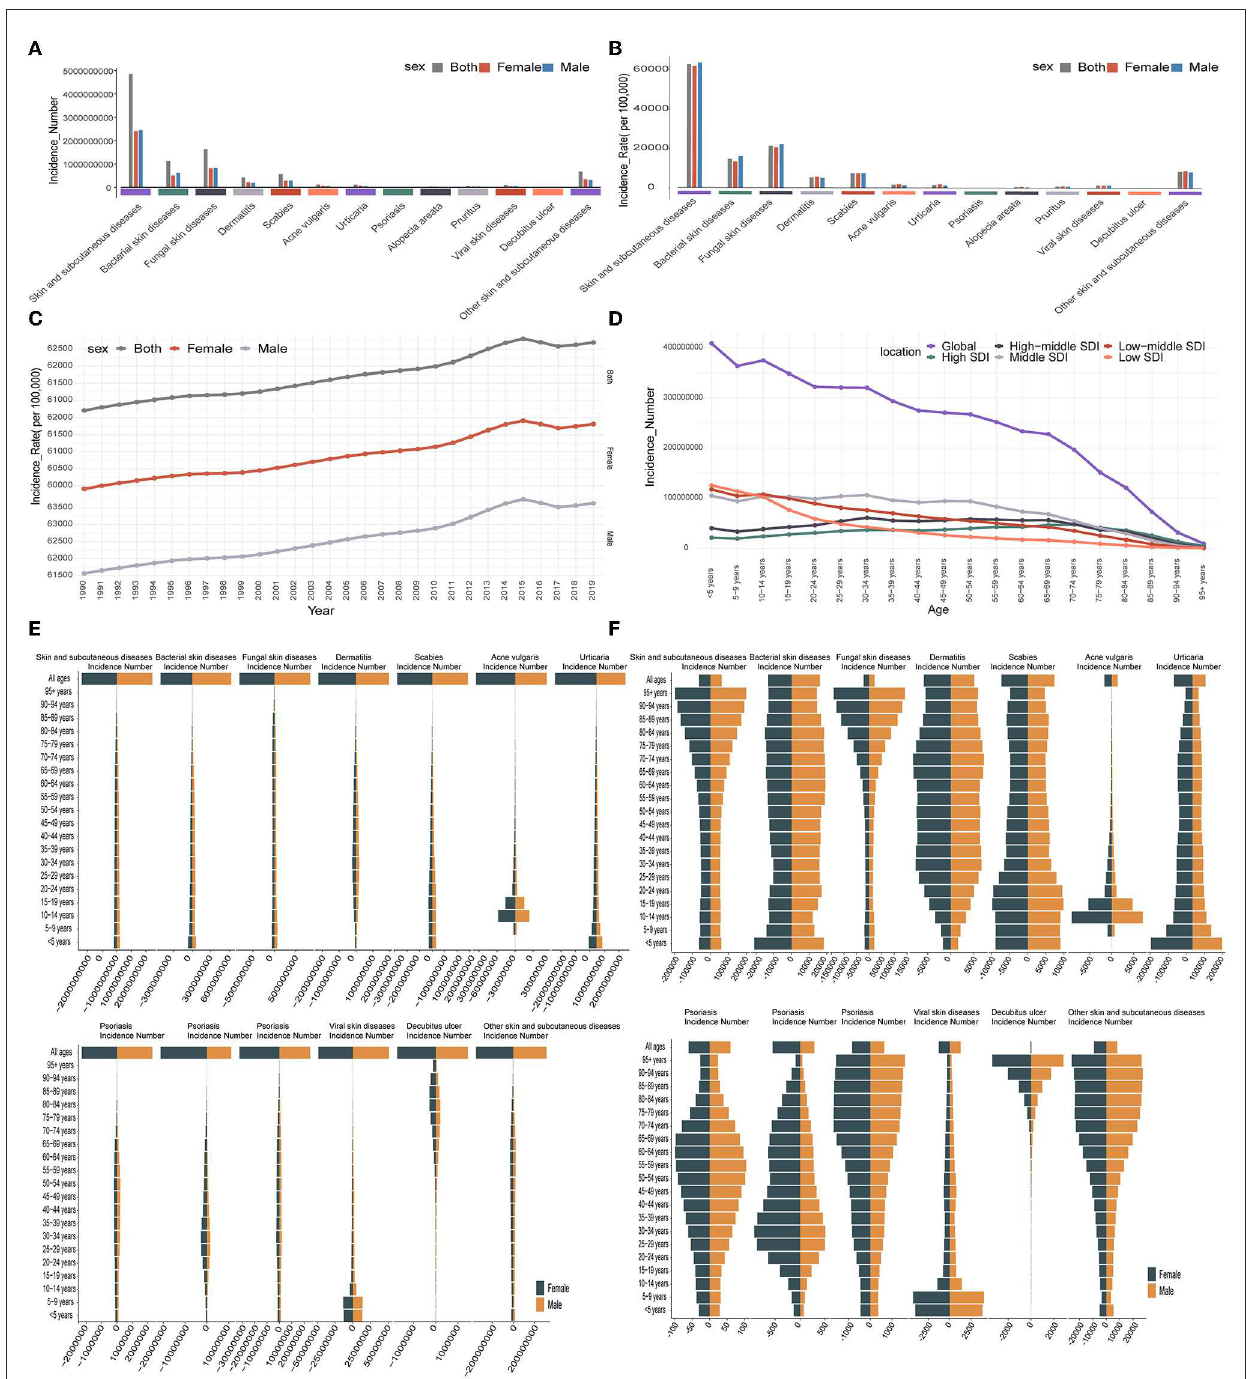
FIGURE2 Skin and subcutaneous diseases burden among different sexes and ages. (A) Each skin and subcutaneous disease’s new cases distributions by sex in 2019. (B) Each skin and subcutaneous disease ASIR distribution by sex in 2019. (C) Global changing trend in each skin and subcutaneous disease ASIR by sex from 1990 to 2019. (D) Distribution of all skin and subcutaneous diseases new cases globally and SDI levels among different age categories in 2019. (E) Distribution of each skin and subcutaneous disease new cases among different age categories in 2019. (F) Distribution of each skin and subcutaneous disease incidence rate among different age categories in 2019. ASIR, age-standardized incidence rate; SDI, sociodemographic index.